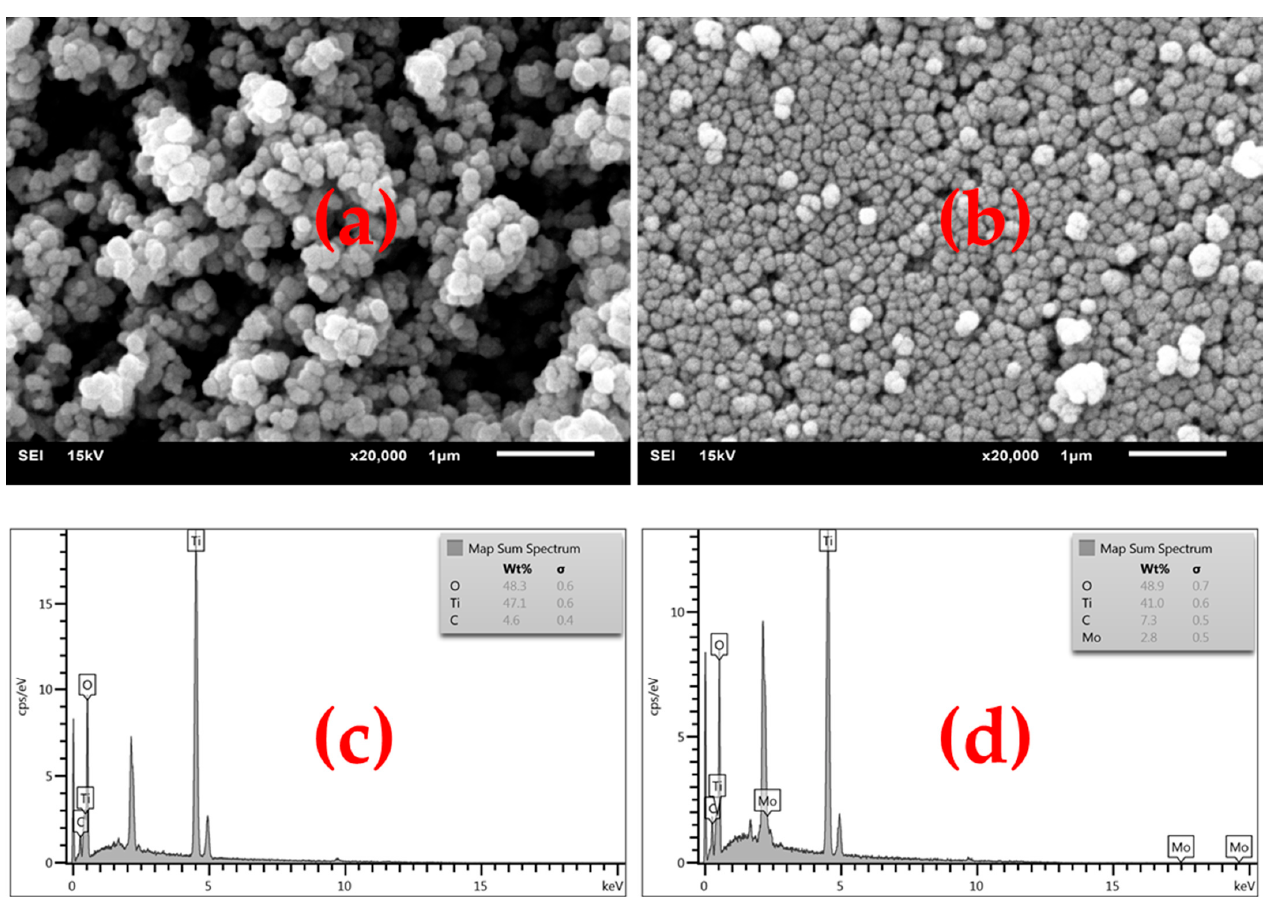
Figure 5. SEM measurement images for ( a ) unmodified HRTiO 2 , and ( b ) Mo/HRTiO 2 , and and their corresponding EDS maps for ( c ) unmodified HRTiO 2 , and ( d ) Mo/HRTiO 2 .